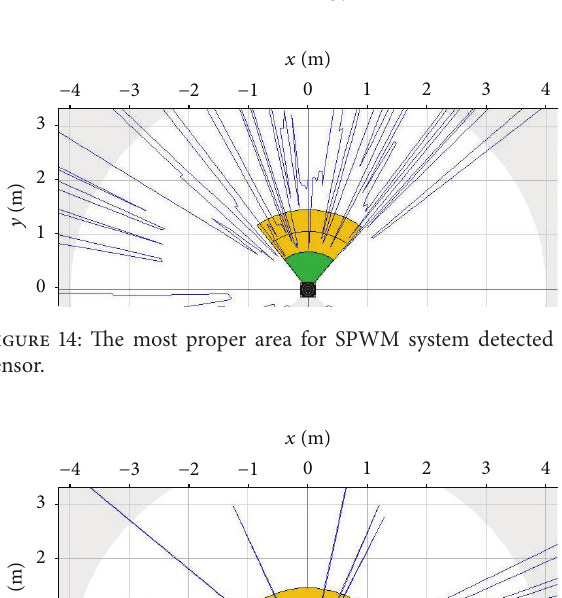
in green in Figure 14. Area scanning image before the